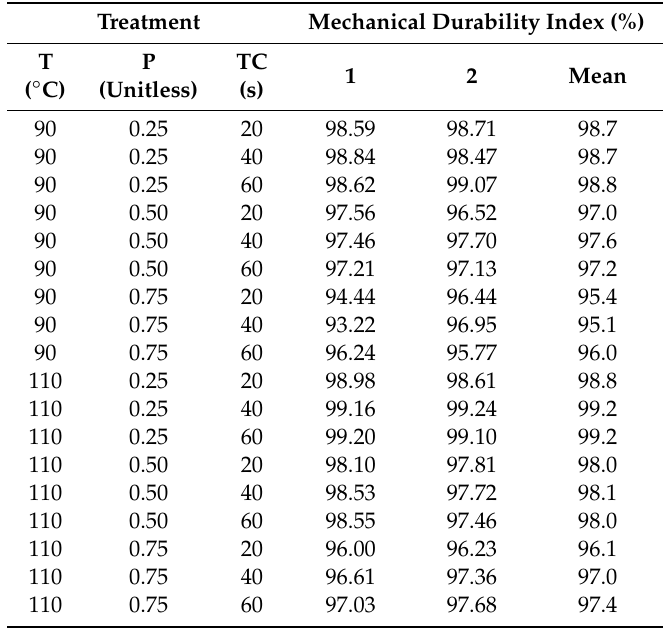
Table 6. Results for mechanical durability index in rice husk and pine sawdust briquettes.